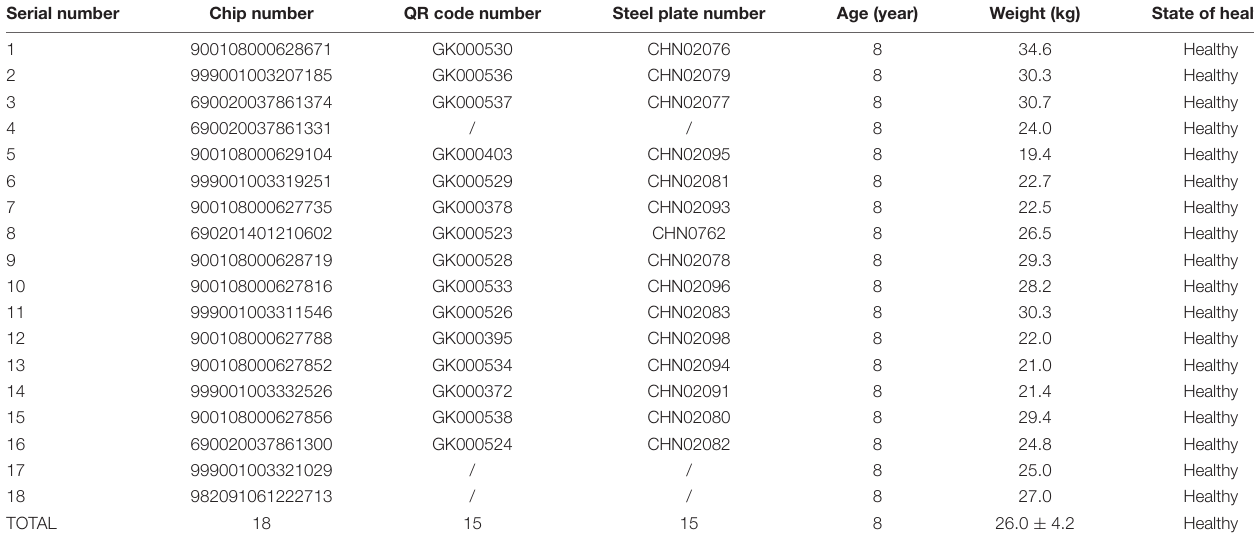
TABLE 1 | Information of released green sea turtles.